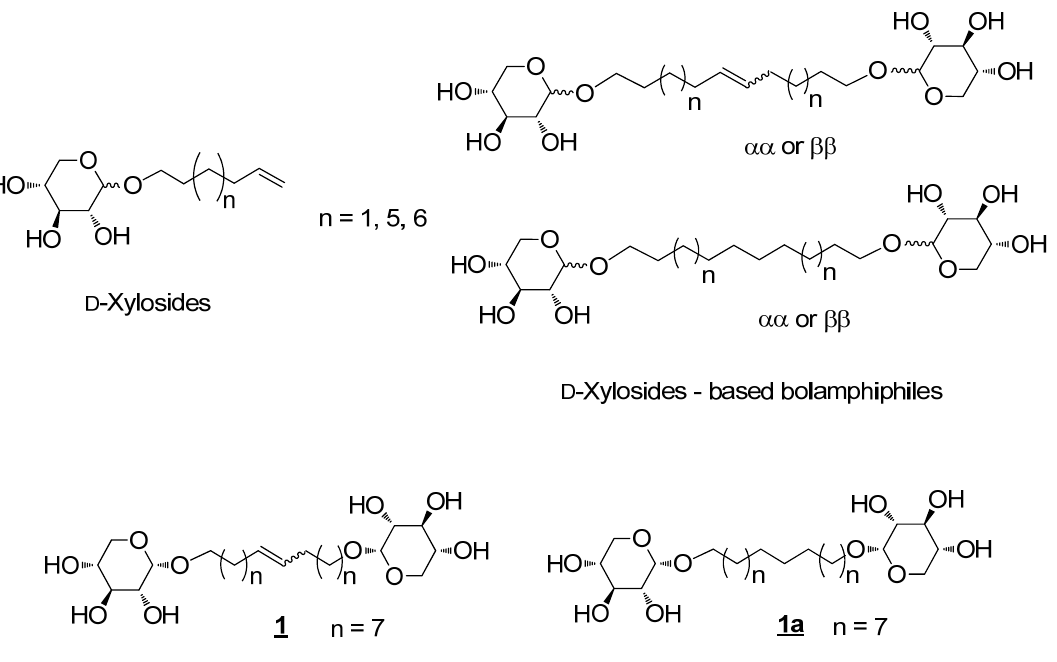
Figure 1. D -xylosides and D -xylosides-based